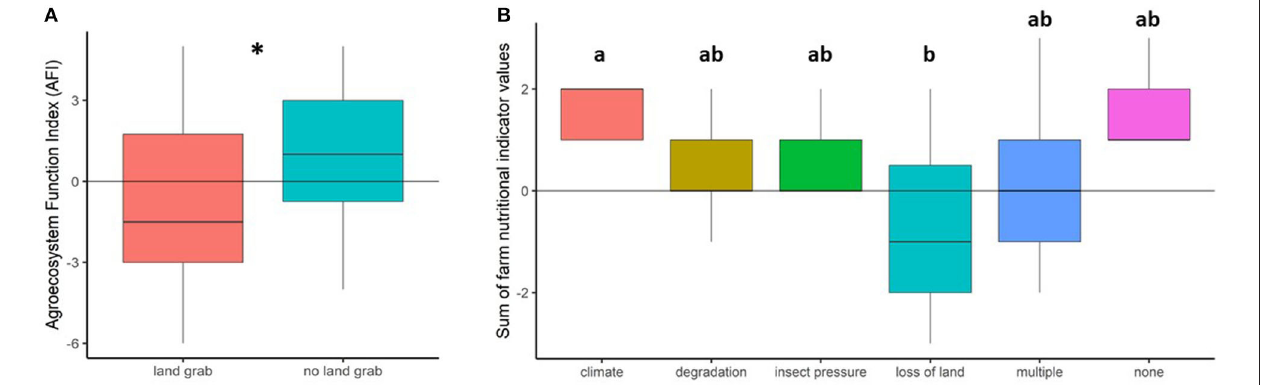
FIGURE 3 | Shocks in smallholder agroecosystems in Sarstún, Guatemala. (A) Shows the Agroecosystem Function Index (AFI) for farms experiencing a major community-level shock, land grabbing, and those subject to only generalized deforestation as a landscape-level shock (no land grab). (B) Represents the suite of household-level shocks experienced by smallholders in Sarstún and their relationships with the nutritional component of the AFI (sum of nutritional indicator values by farm). There were no significant differences by shock type for the ecological component or the overall sum of indicator values, the AFI. N = 60 farms. In (A) , * Indicates p < 0.05. In (B) , different letters indicate significant differences in indicator values for distinct household shocks ( p < 0.05; Tukey’s HSD).